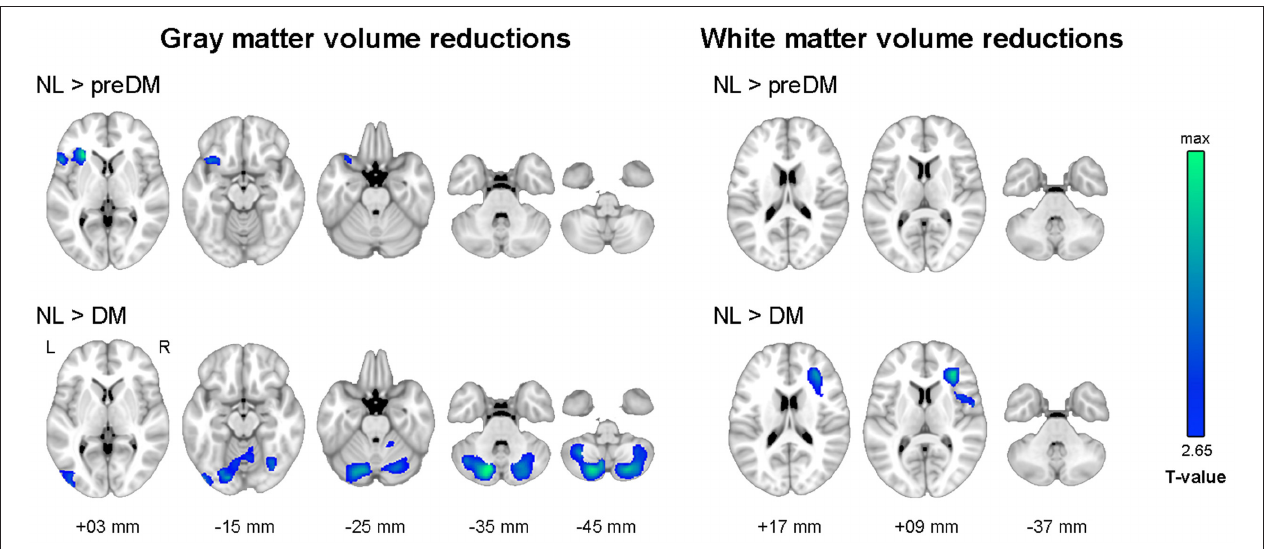
FIGURE 1 | Results of whole-brain analyses showing reduced gray and white matter volume in dysglycemia compared to normal glucose tolerance. Family-wise error corrected p < 0.05 at cluster level with underlying voxel level of uncorrected p < 0.005. NL, normal control group; preDM, prediabetes group; DM, type 2 diabetes